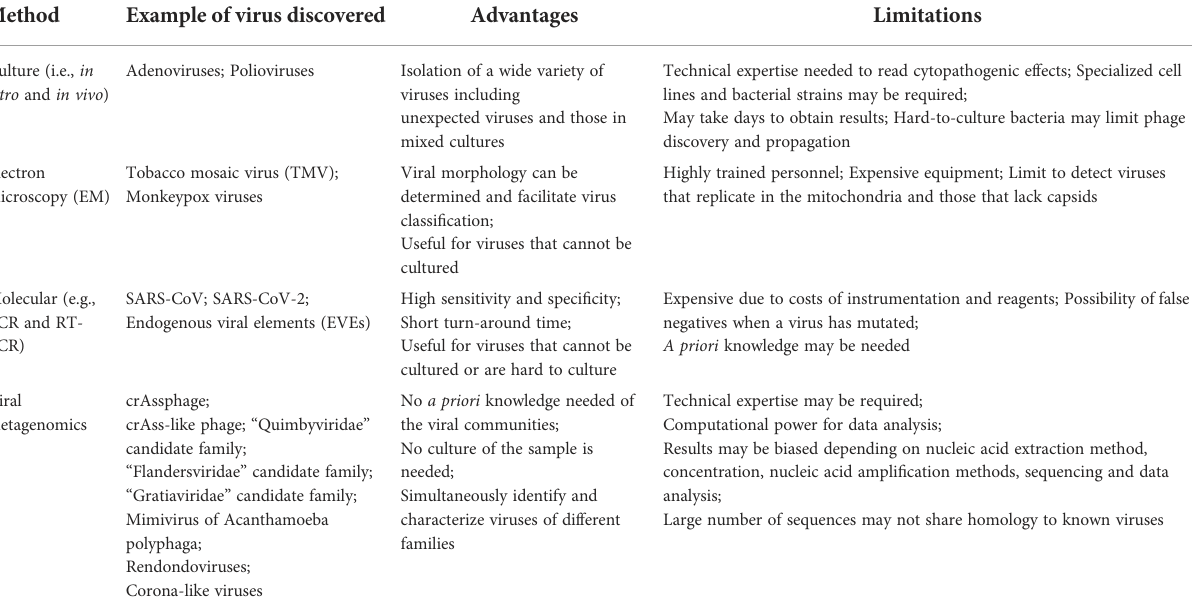
TABLE 1 Methods used for virus